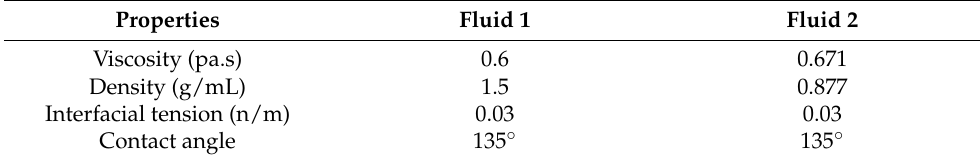
Table 1. Basic parameters of the two fluids.